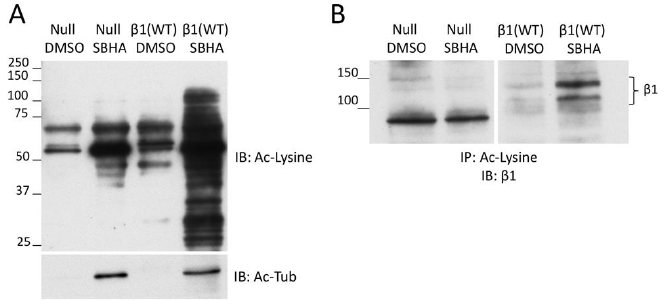
Figure 3. Deacetylase inhibitor treatment promotes β1 integrin acetylation. ( A ) GD25 β1(null)